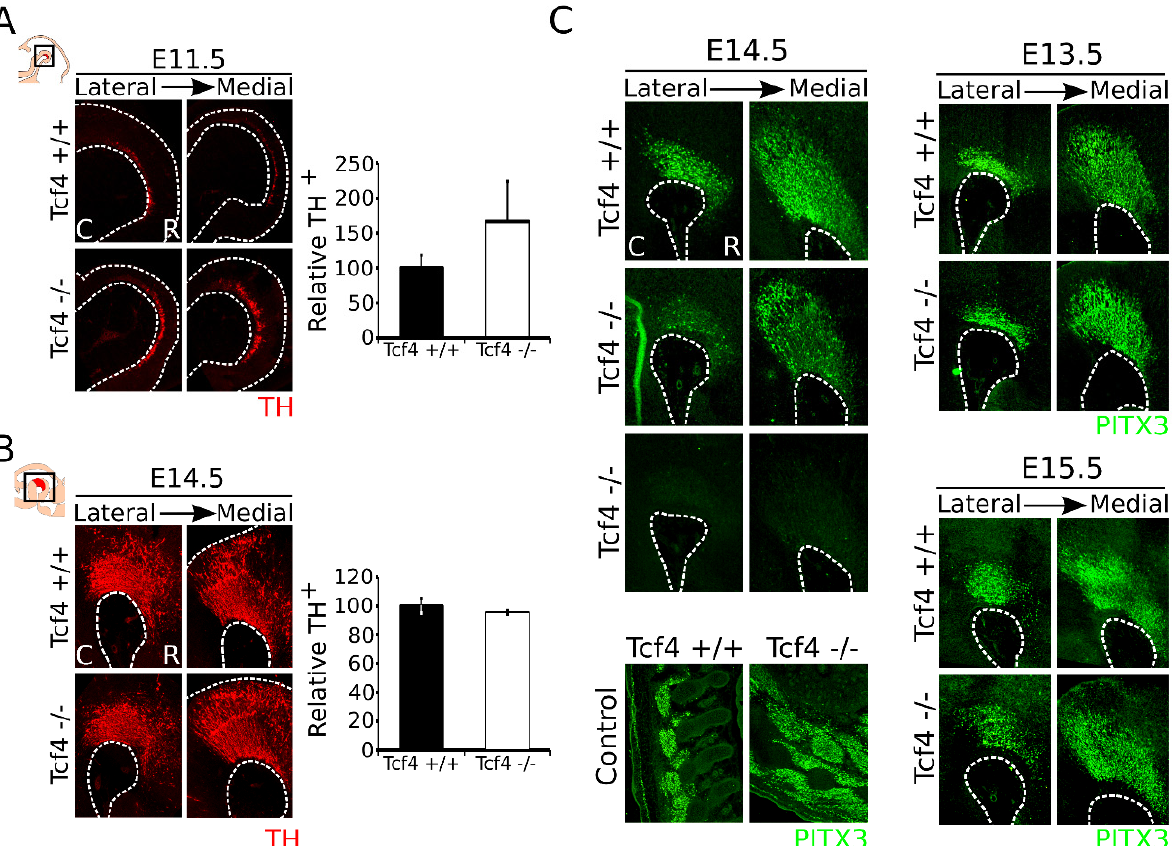
Figure 2. The Tcf4 mutant shows an upward trend in the amount of TH + cells at E11.5, which normalizes at E14.5. ( A ) Loss of Tcf4 leads to an upward trend in TH-expressing cells (red) in the mutant embryo at E11.5. Quantification of the TH + neurons shows an upward trend in Tcf4 mutant embryos (white bar) compared to WT embryos (black bar), although this is not significant (WT n = 3; mutant n = 5; p = 0.06 one-tailed). WT was set at 100%. C: caudal, R: rostral. ( B ) Loss of Tcf4 has no apparent effect on the morphology and the presence of TH-expressing neurons (red) in the midbrain at E14.5. Quantification of TH + neurons in the WT (black bar) and Tcf4 mutant (white bar) midbrain does not show a difference in the amount of the TH-expressing neurons (n = 3; two-tailed). WT was set at 100%. C: caudal, R: rostral. ( C ) Expression of PITX3 (green) is affected in some Tcf4 mutant embryos at different levels in the embryonic midbrain at E14.5. This effect on PITX3 was not seen in the musculature of the tested embryos. Furthermore, at E13.5 and E15.5 no clear difference in PITX3 (green) expression level or area was detected. C: caudal, R: rostral.